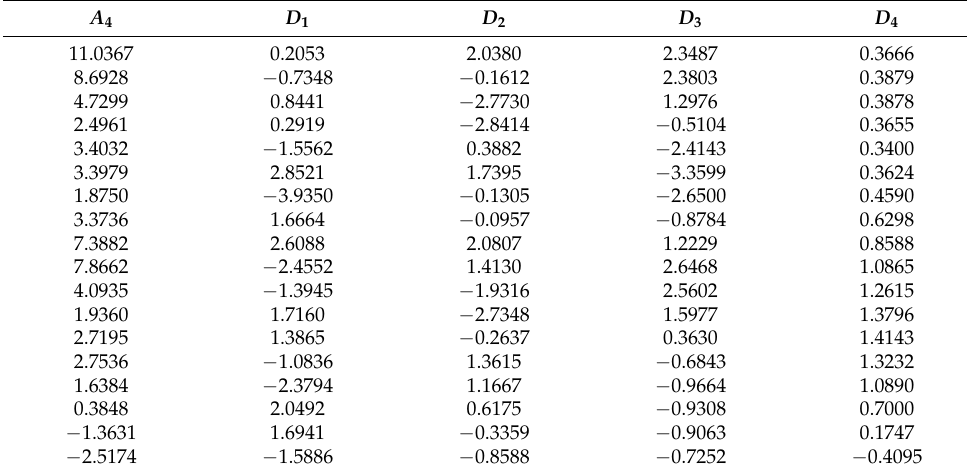
Table 3. Four-level wavelet decomposition of V 2 .